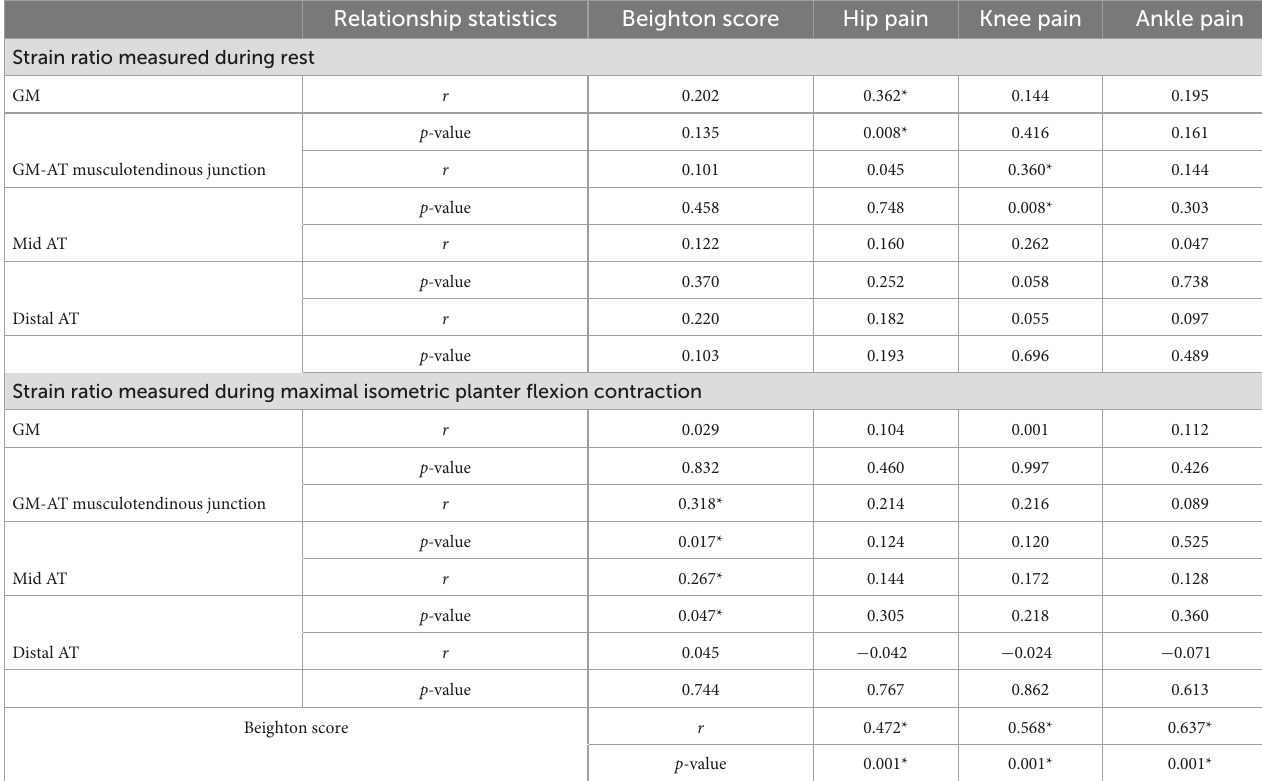
TABLE 4 The relationship between the intensity of joint pain (measured with visual analogue scales), Beighton score, and the strain ratio (measured with compression sonoelastography of the GM-AT complex). Relationship statistics Beighton score Hip pain Knee pain Strain ratio measured during